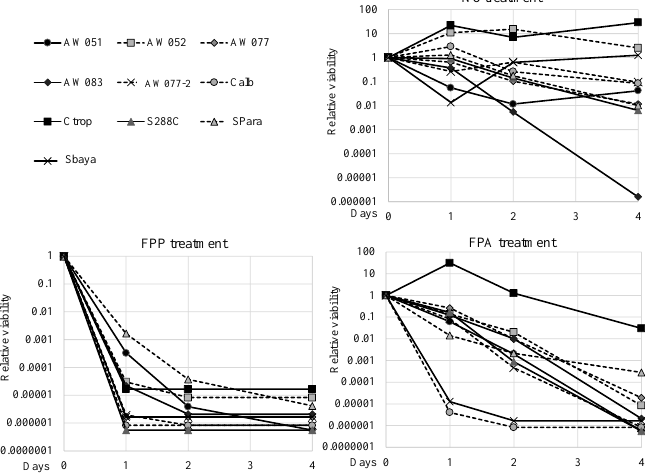
Figure 7. Toxicity of FPP and FPA are well conserved. Yeast cells were inoculated to Synthetic Complete medium overnight, then inoculated to MM2 medium with 500 mg L −1 FPP, FPA, or no drug, and incubated at 37 °C in an immobile 96-well plate. Culture viability was assessed over time using the Tadpoling method. Relative viability was assessed by dividing the number of CFUs on day 0, 1, 2, or 5 by the number of CFUs on day 0. The average of three independent trials is shown.